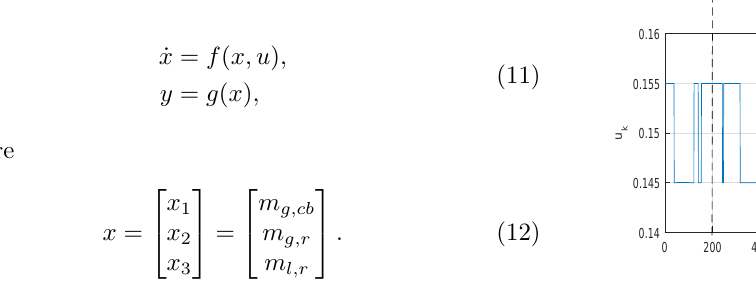
and y m = 188 . 3 (Fig.